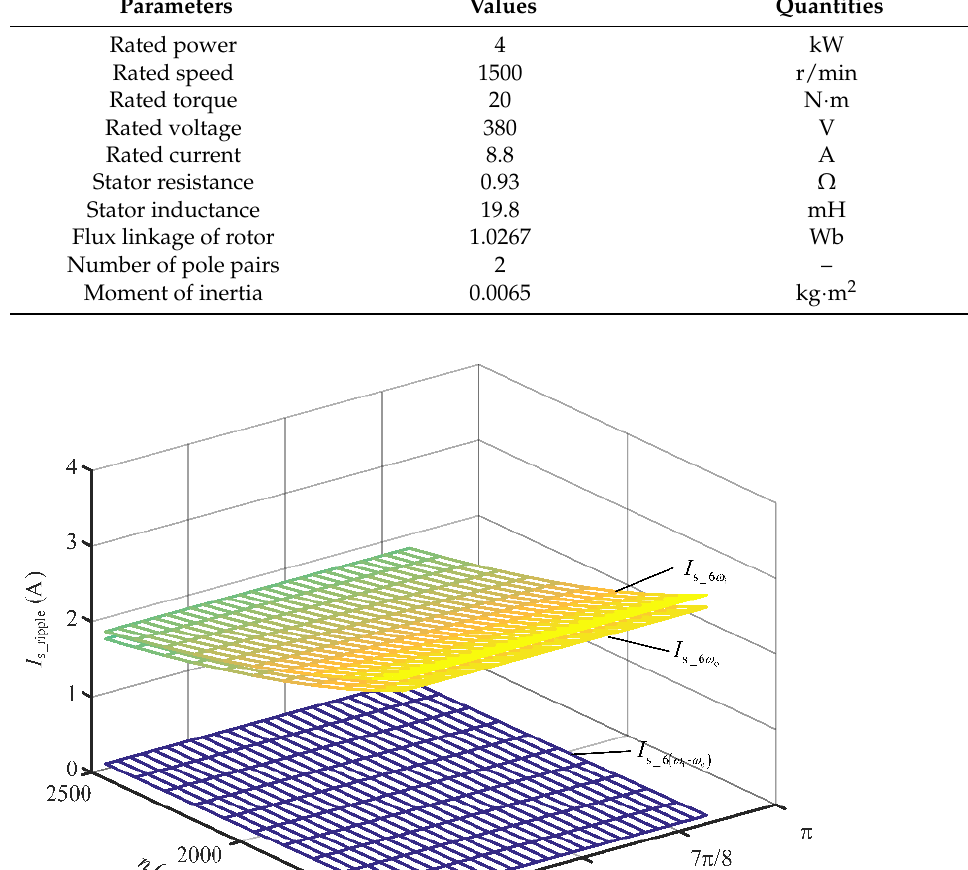
Table 2. Parameters of SPMSM.